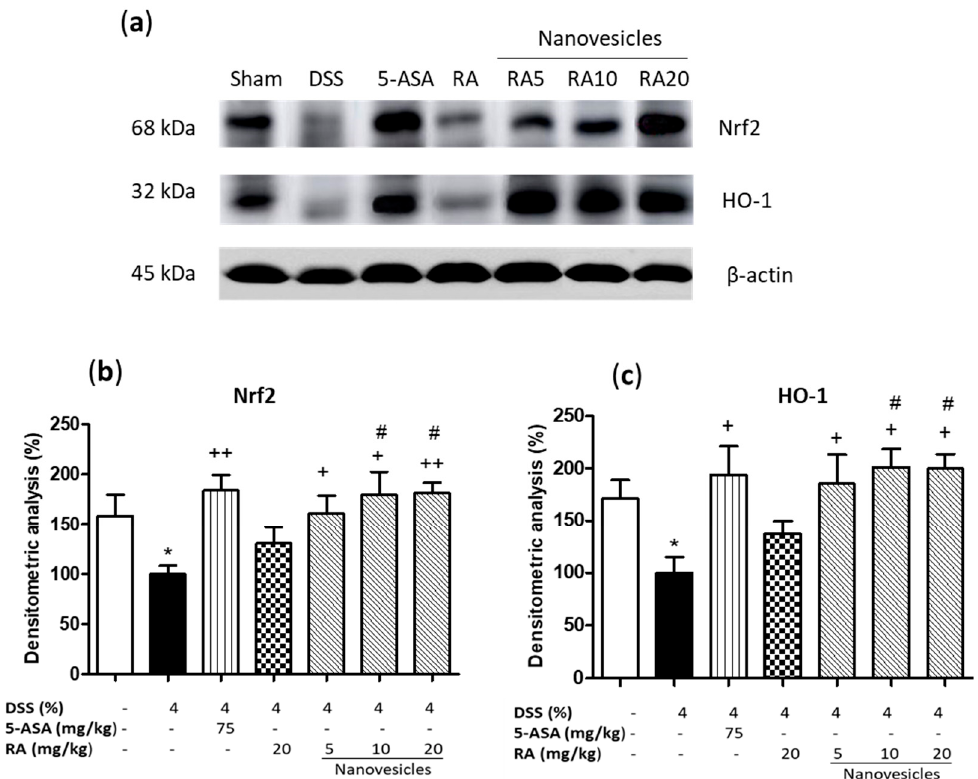
Figure 6. Effects of rosmarinic acid (RA)-loaded nanovesicles (5, 10 and 20 mg/kg), RA (20 mg/kg) or aminosalicylic acid (5-ASA) (75 mg/kg) on nuclear factor erythroid-related factor 2 (Nrf2) and heme oxygenase-1 (HO-1) expression in DSS-induced colitis in mice. ( a ) Representative Western blot analysis. Densitometry analysis of ( b ) Nrf2, and ( c ) HO-1 were performed following normalisation to the control ( β -actin housekeeping gene). Results are representative of five experiments performed on different simples. Data are expressed as the mean ± SEM. Mean value was significantly different compared with the sham group (* p < 0.05; Mann–Whitney U test). Mean value was significantly different compared with DSS group (+ p < 0.05, ++ p < 0.01; Kruskal–Wallis test) or RA group (# p < 0.05; Kruskal–Wallis test).